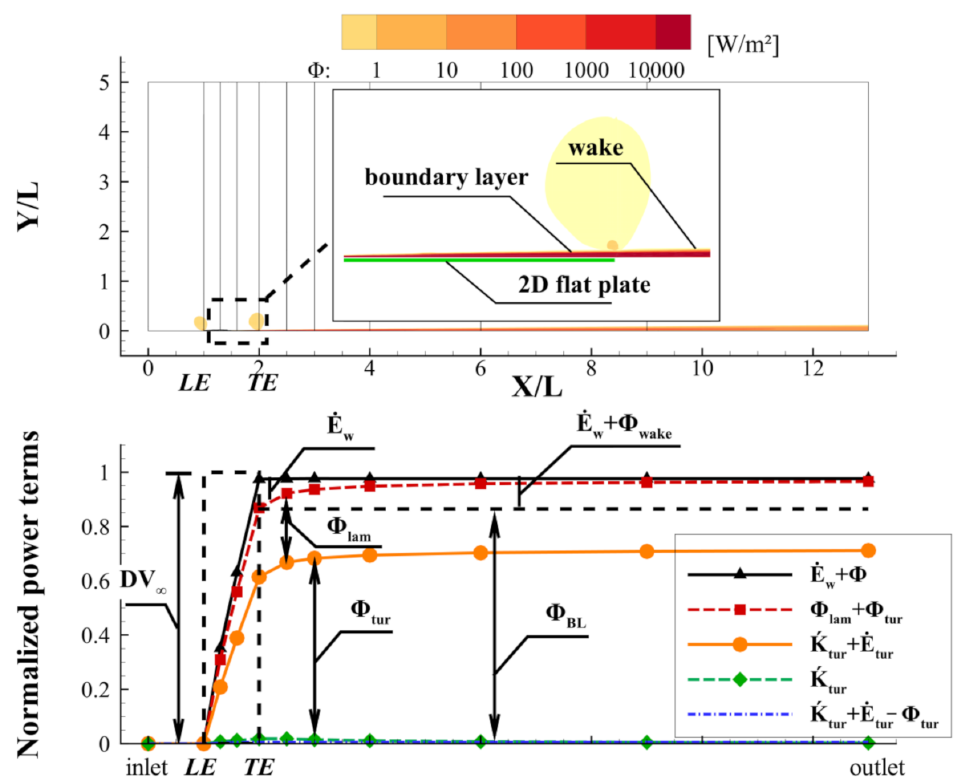
Figure 13. Contours of the integrand of viscous dissipation ( top ) and the power bookkeeping of the 2D flat plate ( bottom ) in turbulent flow (steady RANS with k- ω -sst